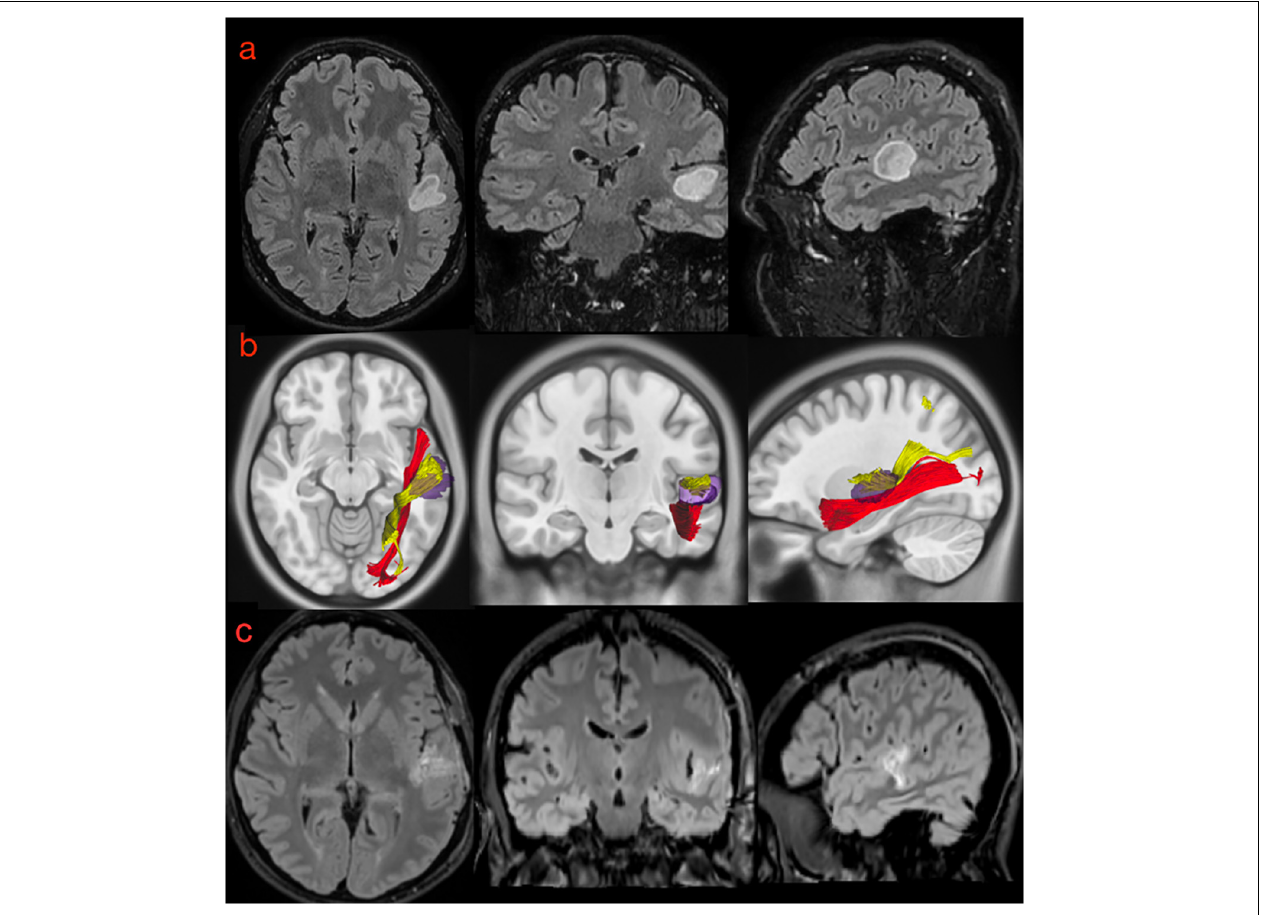
FIGURE 11 | (a) Preoperative morphological MRI T2-Flair sequences of illustrative case #2. The hyperintensity signal on axial, coronal, and sagittal (first row) views show a suspected low-grade glioma involving the posterior portion of the superior temporal gyrus very close to anterior temporal transverse gyrus and the planum temporale. (b) The normalization of the tumor lesion volume within the MNI space allowed us to merge our anatomical results on the MdLF dissection with the patient-specific anatomy. According to our results, the tumor invaded the pMdLF (yellow) but not the aMdLF (red). (c) Postoperative MRI T2-Flair images showing a complete resection of the tumor